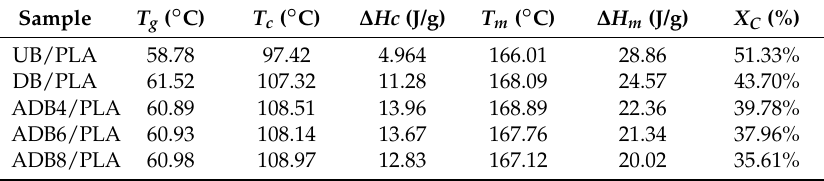
Table 4. Typical thermal parameters of DSC analysis of various BF/PLA